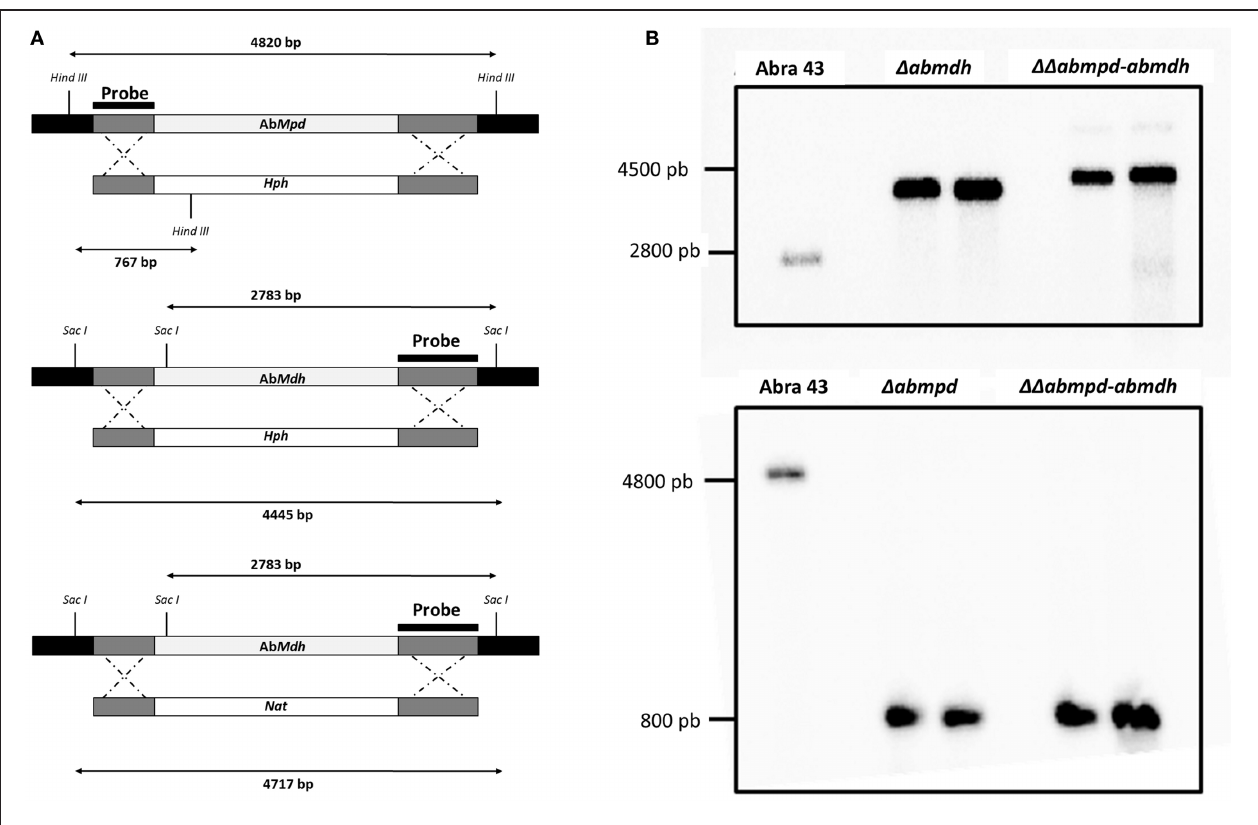
FIGURE 3 | Verification of deletion mutants. (A) Schematic representation of the AbMpd and AbMdh loci (gray boxes), replacement constructs with the HygB resistance gene ( Hph ) or the nourseotricin resistance gene ( Nat ) cassettes (white boxes) and flanking sequences (dark gray boxes). The positions of Hin dIII and Sac I sites are indicated. (B) Southern hybridization